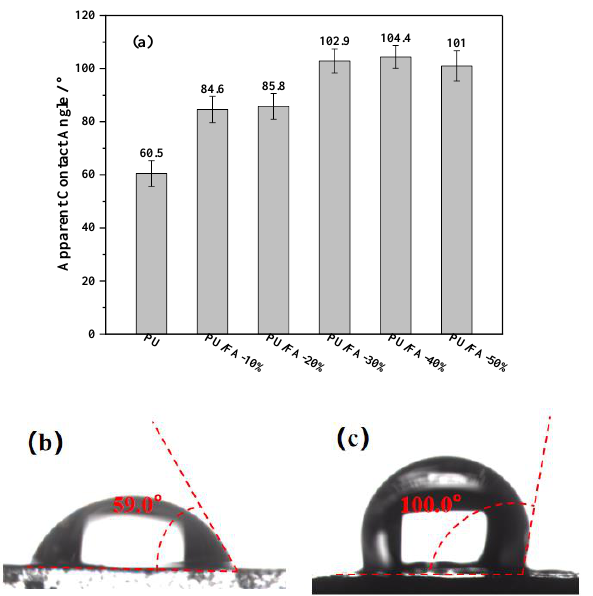
Figure 10. ( a ) PU/FA composites apparent contact angle and apparent contact angle photos: ( b ) PU; ( c ) PU/FA-50%. ( c )